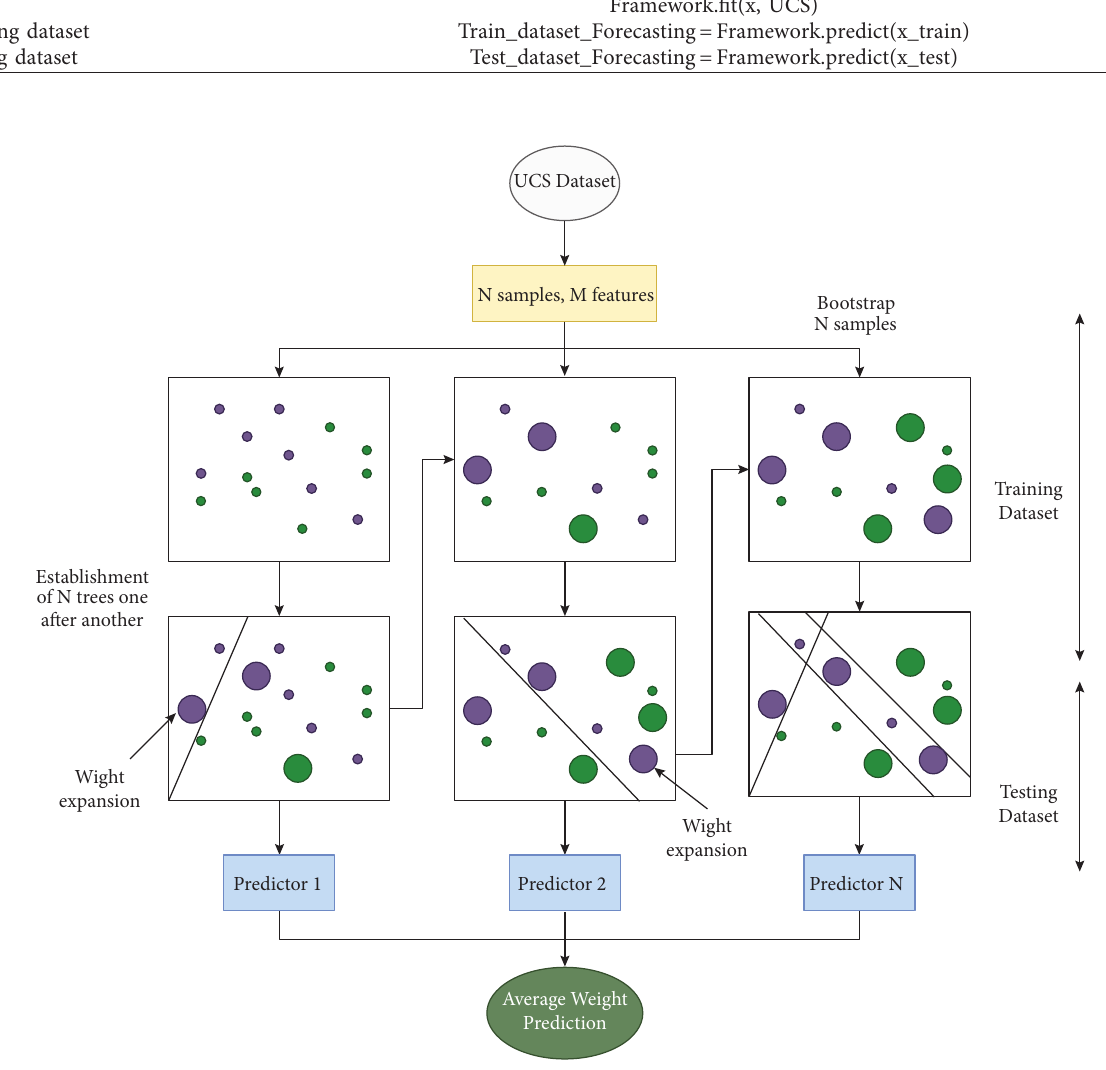
Figure 6: Description of Catboost employed in this study.